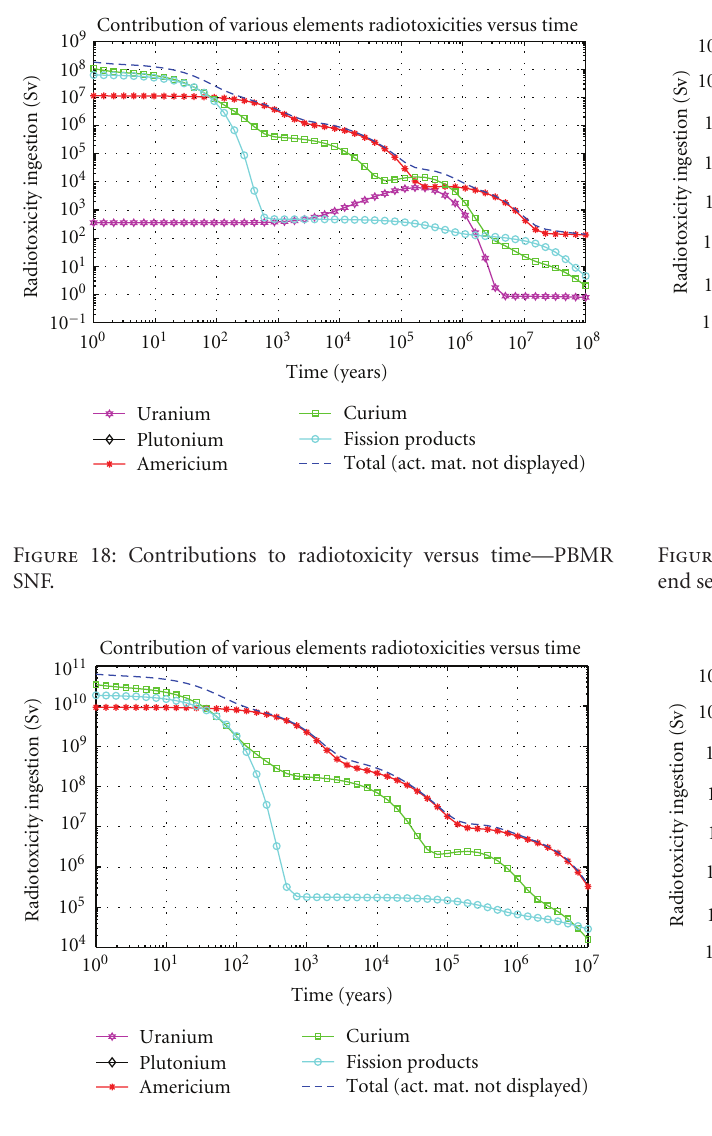
Figure 19: Contributions to radiotoxicity versus time—GCFR SNF end first cycle.